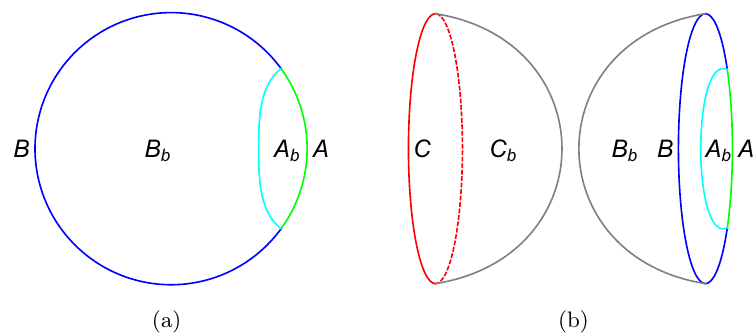
Figure 7 . Puri(cid:12)cation of the thermal density matrix in gravity. In (b) there is no macroscopic horizon that connects the two asymptotic AdS regions A b [ B c and C b . However, there are still microscopic connections between A b [ B c and C b , and the two boundaries A [ B and C . We have the mutual information I ( A b ; C b ) > 0 and I ( A; C ) >